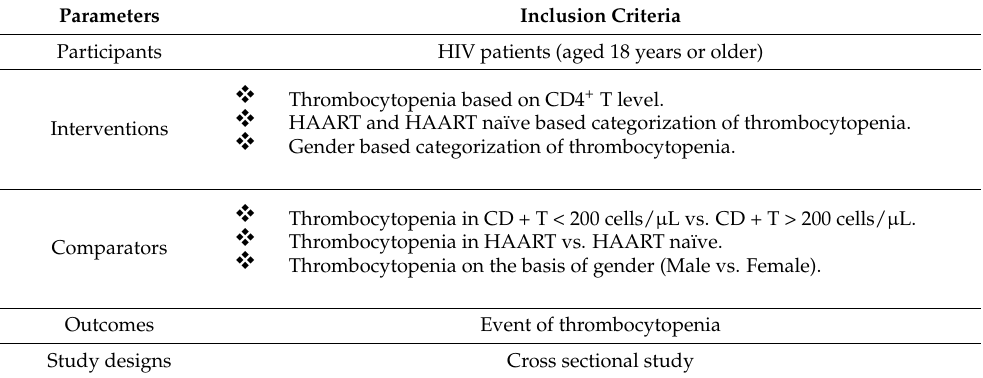
Table 1. PICOS criteria for study selection.